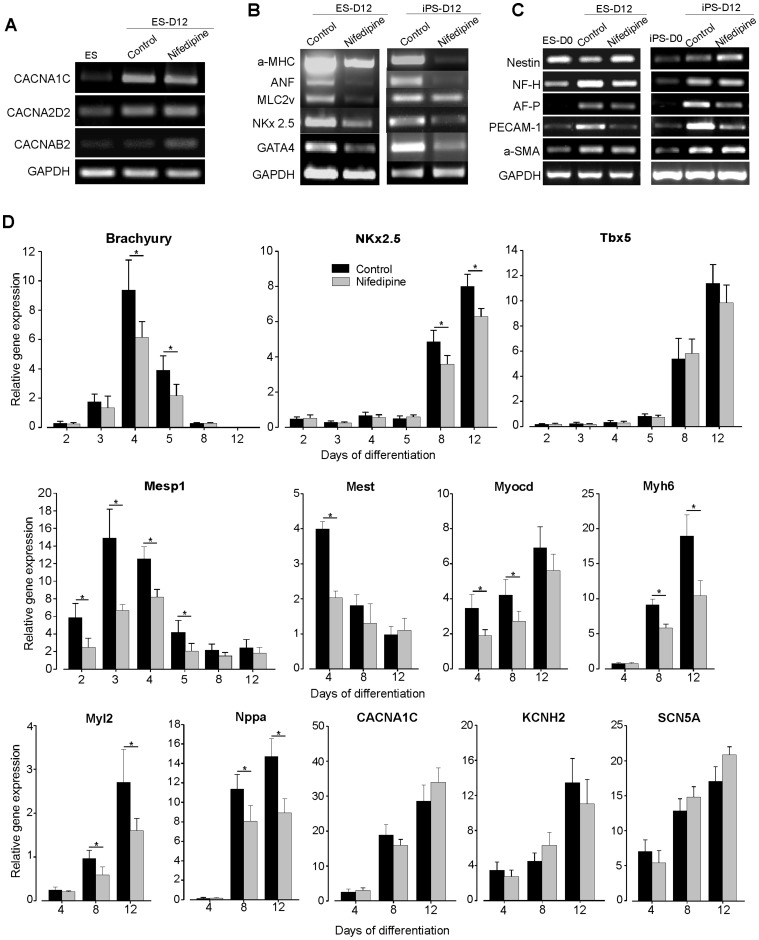
Nifedipine repressed the expression level of most specific cardiac and mesoderm genes.(A) RT-PCR for L-type Ca2+ channel α-subunit isoforms in undifferentiated ES cells and CMs at day 12 of differentiation, demonstrating (i) presence of L-type Ca2+ channel mRNA even in undifferentiated ES cells and (ii) an increase in mRNA encoding the CaV1.2 subunit of the channel. (B) RT-PCR analyses of cardiac-specific and transcription factors α-MHC/Myh6, ANF/Nppa, MLC2v/Myl2, NKx2.5 and GATA4 in beating cluster at day 12 of both ES and iPS differentiation. (C) RT-PCR analyses of representative markers, PECAM-1 (mesoderm, endothelial cell), AFP (endoderm, early hepatocyte progenitor), Nestin and NF-H (ectoderm, neural progenitor) and α-SMA (mesoderm) in ES and iPS beating cluster at day 12 of differentiation. (D) Quantitative real-time PCR analyses of mesoderm and cardiac markers and specific transcript (Brachyury T, Mesp1, NKx2.5, Tbx5, Mest, Myocd, Myh6/α-MHC, Myl2/MLC2v, and Nppa/ANF), as well as cardiac ionic channels (CACNA1c, KCNH2 and SCN5A) expression at different stage of ES cell differentiation. GAPDH was used as housekeeping gene and served to normalize the result. Results are reported as the means±SEM (n = 3). *P<0.05 vs. control CMs.